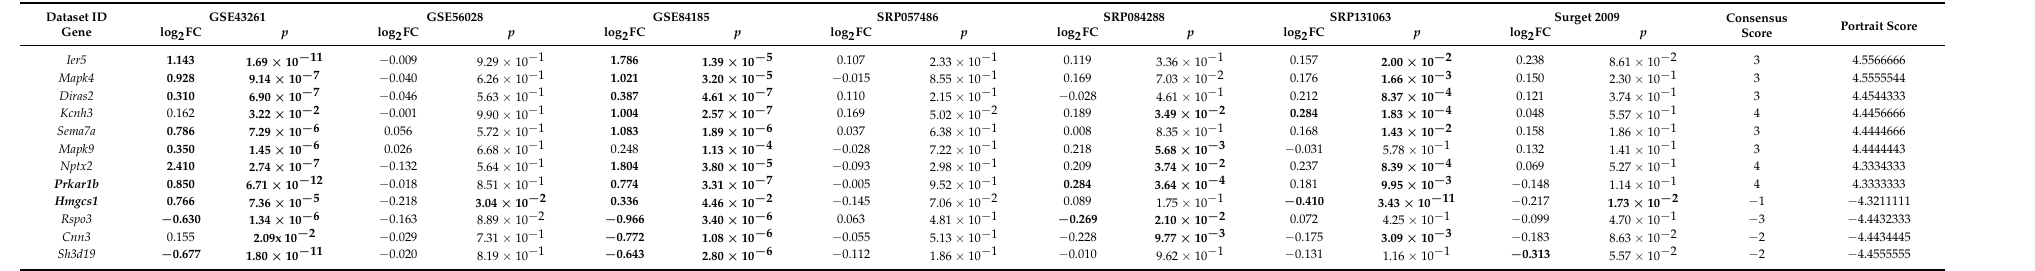
Table 3. Signature of FLX effect in stressed animals (portrait score